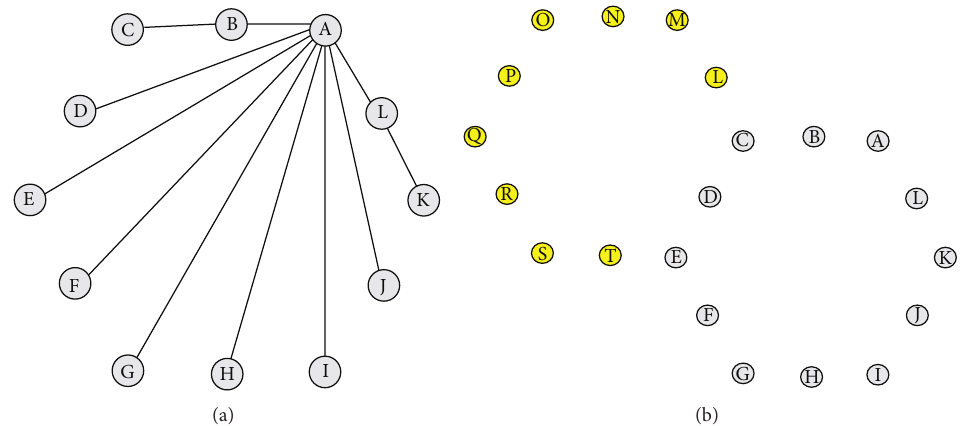
Figure 1: (a) Hexagonal network showing actuator-sensor paths from transducer A (left) and (b) expansion of a single unit cell (right).